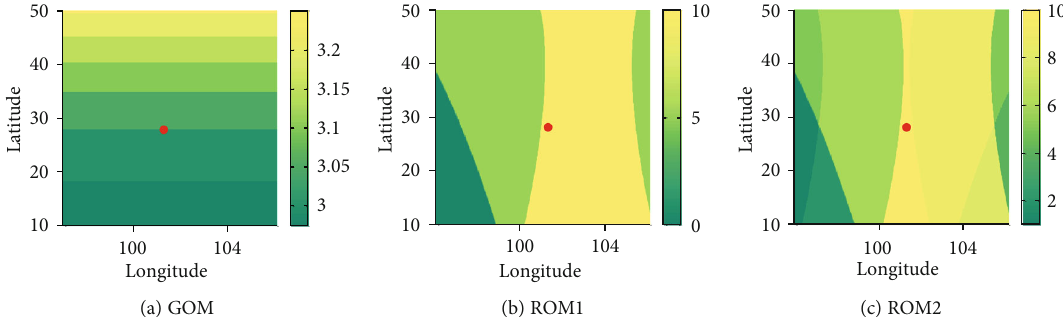
Figure 12: Average observation numbers per day of di ff erent